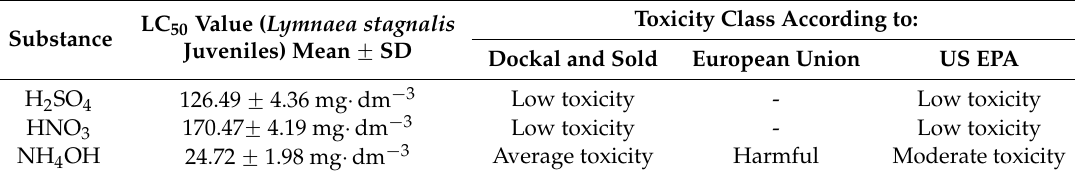
Table 6. Assessment of acute toxicity of pollutants on Lymnaea stagnalis after hatching (LC 50 /24 h).